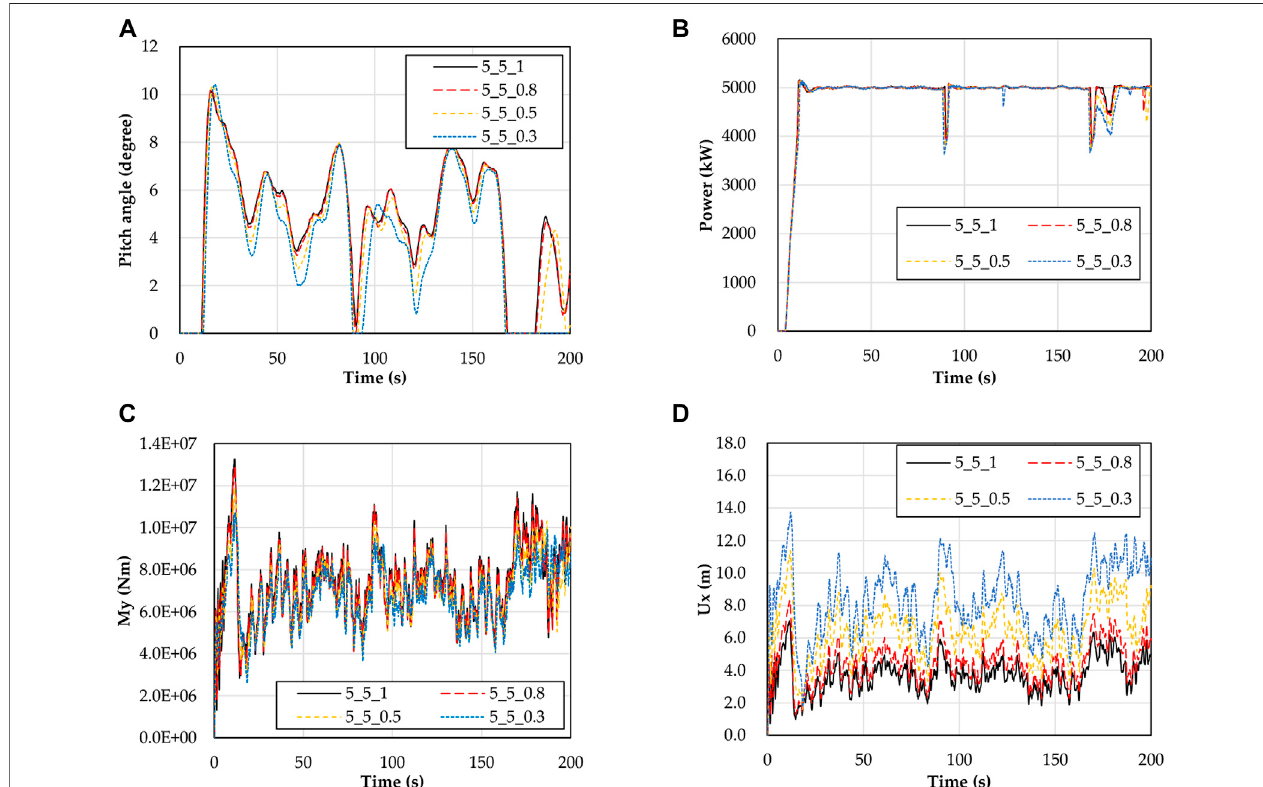
FIGURE 8 | The aeroelastic response of the models with fl ap-wise stiffness adjusted.